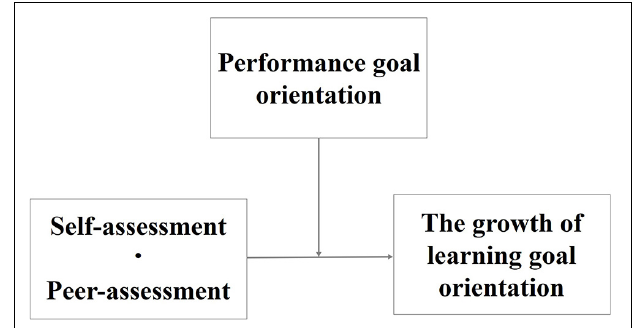
FIGURE 1 | Outline of the